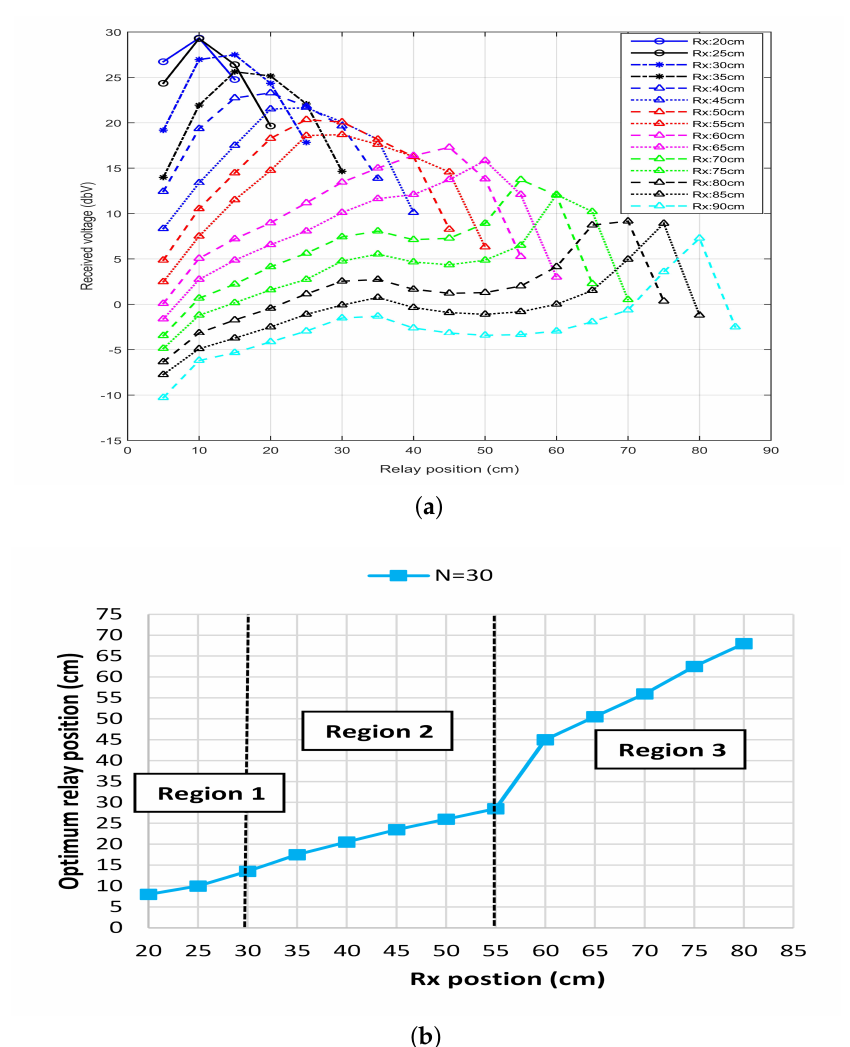
Figure 5. Received voltage and optimal relay position when r = 15 cm and N = 30, ( a ) received voltage vs. relay position under different receiver positions, and ( b ) optimal relay position vs. receiver